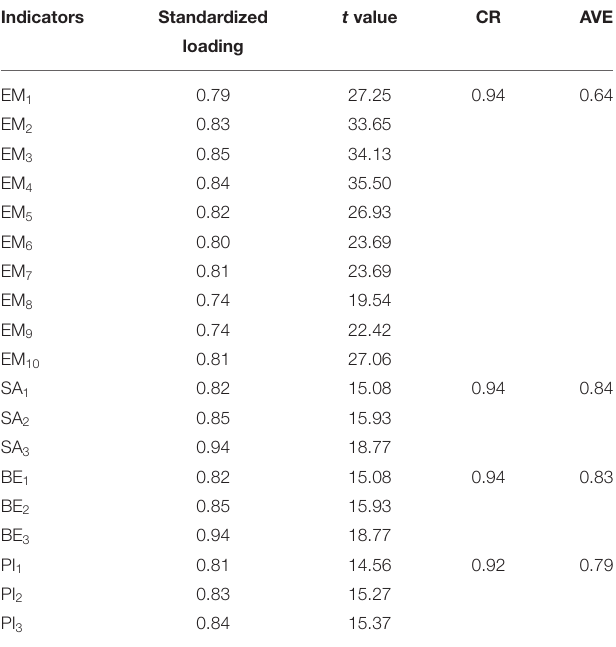
TABLE 1 | Characteristics of the sample ( N = 238 actual participants). Characteristics